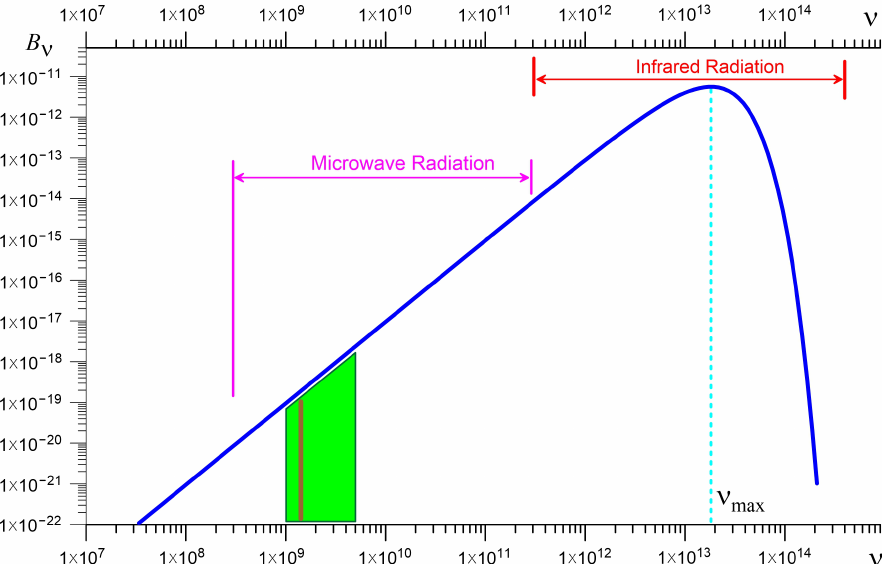
Figure 2. The spectral density of electromagnetic radiation B ν at temperature T = 37 ◦ C (blue line): the left axis is the dependence B ν ( ν ; T ) , ν is the radiation frequency ( [ ν ] = Hz). The magenta line shows the range for microwave radiation. Other colored lines are explained in the